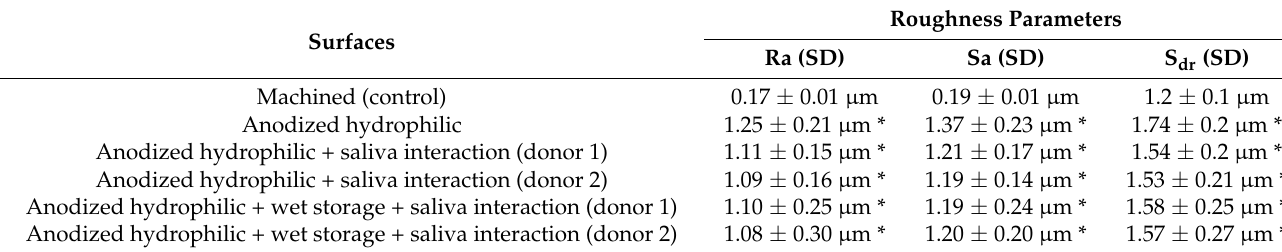
Table 2. Roughness parameters before/after saliva interaction on the anodized